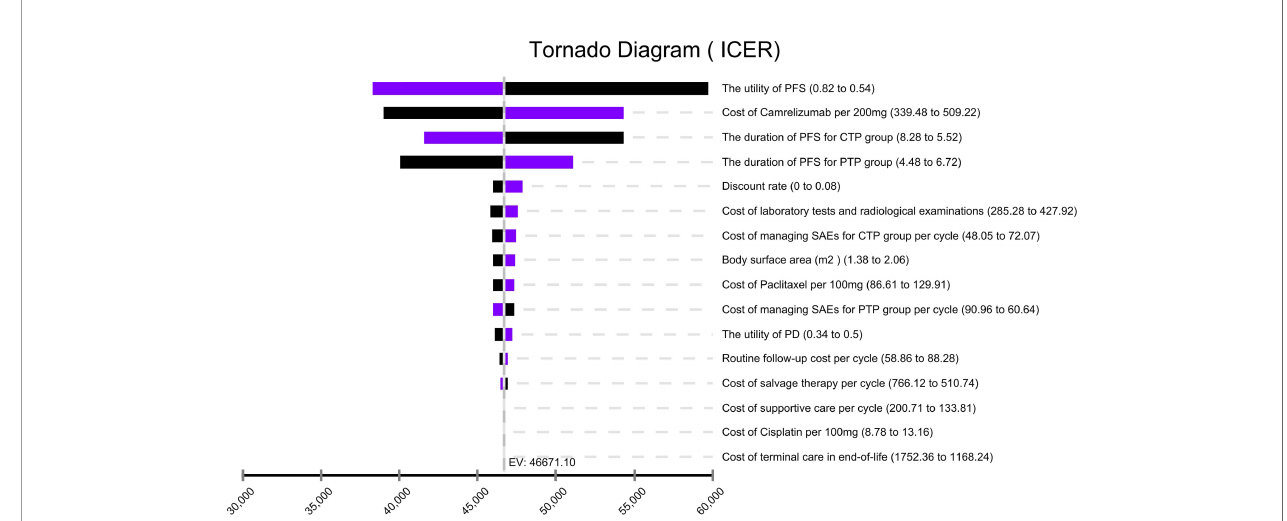
FIGURE 3 | Tornado diagram of one-way sensitivity analysis. It summarized the results of one-way sensitivity analysis, which listed in fl uential parameters in descending order according to their effect on the ICER over the variation of each parameter value. ICER, incremental cost-effectiveness ratios; CTP, camrelizumab- chemotherapy; PTP, placebo-chemotherapy; PFS, progression-free survival; PD, progressive disease; SAEs, serious adverse